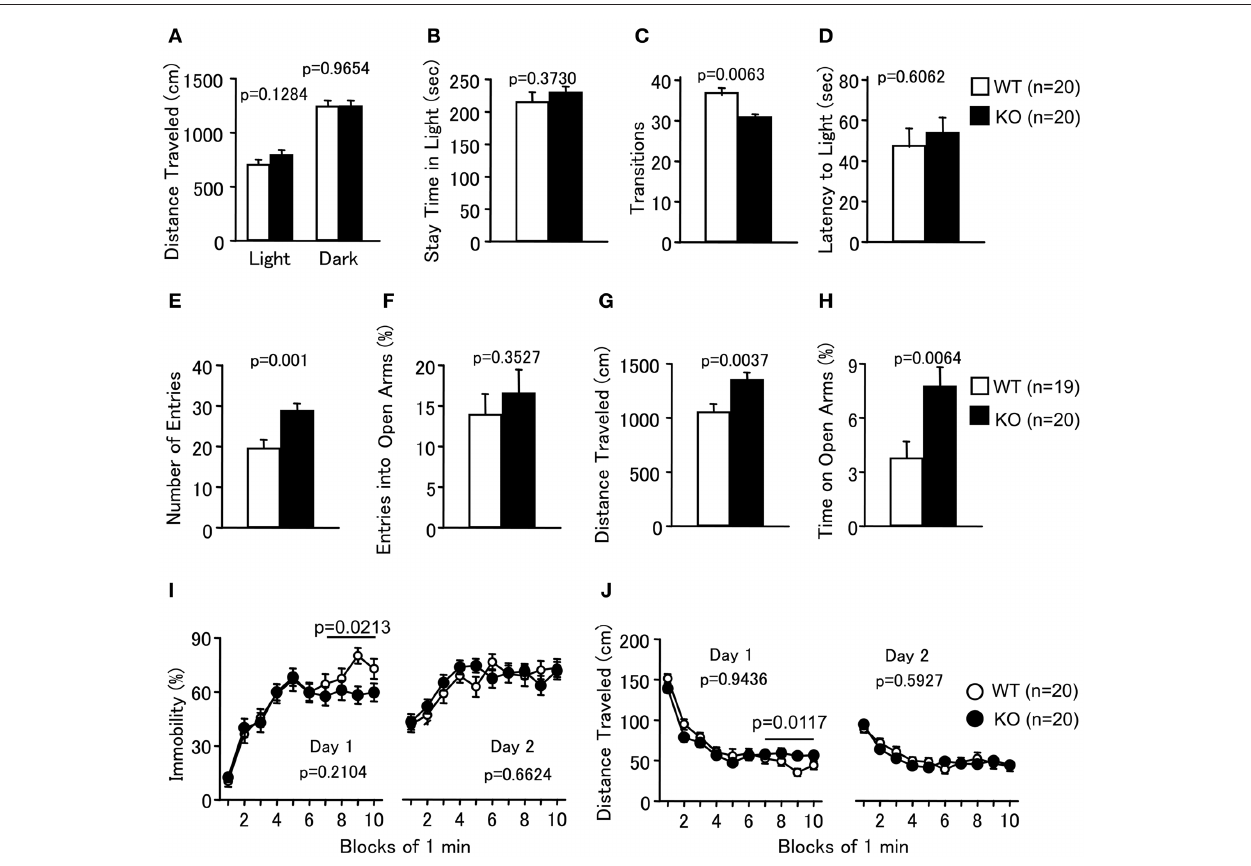
FIGURE 3 | Abnormal anxiety-like and slightly decreased depression-like behaviors in PACAP knockout mice. (A–D) Light/dark transition test: the distance traveled in the light/dark compartments (A) , time spent in the light compartment (B) , number of light/dark transitions (C) , and latency to enter the light compartment (D) were shown. (E–H) Elevated plus maze: the number of arm entries (E) , percentage of entries into the open arms (F) ,